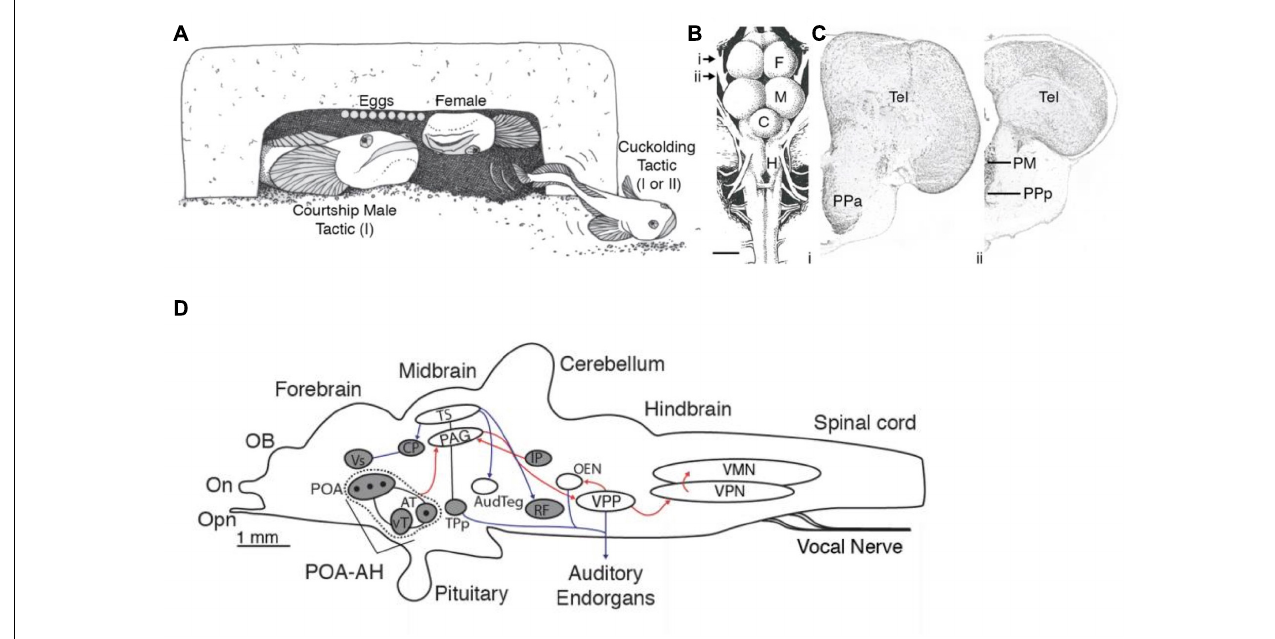
FIGURE 5 | Alternative male reproductive morphs, preoptic area and galanin expression in the vocal circuitry of plainfin midshipman, Porichthys notatus. (A) Male midshipman exhibit alternative patterns of reproductive tactics. Type I males guard nests under rocky shelters, from where they broadcast a long duration (up to 2 h), multi-harmonic advertisement call known as a hum to attract females for spawning. Type II males do not exhibit these behaviors, but instead satellite (as shown here) or sneak (within the nest) spawn trying to steal egg fertilizations from resident type I male. Type I males that are small in body size also sneak or satellite spawn when they are unable to have their own nest. See text for more details. (B) Dorsal view of midshipman brain. Arrows indicate level of sections shown to the right. Scale bar represents 1 mm. (C) Transverse sections through midshipman brain at rostral (i) and caudal (ii) levels of the preoptic area (see panel B ). (D) Distribution of immunoreactive galanin expression differs between male and female midshipman. Figure shows sagittal view with major nuclei in the auditory and vocal systems. Black dots indicate location of Gal-ir somata. Shading indicates brain regions having Gal-ir fibers in females and both male morphs, whereas unshaded regions contain Gal-ir fibers in both male morphs that are greatly reduced or absent in females. Red and blue lines indicate connections within the vocal and auditory systems, respectively. Arrowheads show direction of connections. Lines without arrowheads indicate reciprocal connections. C, cerebellum; F, forebrain; H, hindbrain; M, midbrain; PM, magnocellular preoptic area; PPa, anterior parvocellular preoptic area; PPp, posterior parvocellular preoptic area; Tel, telencephalon. Adapted from Tripp and Bass (2020) and Tripp et al.